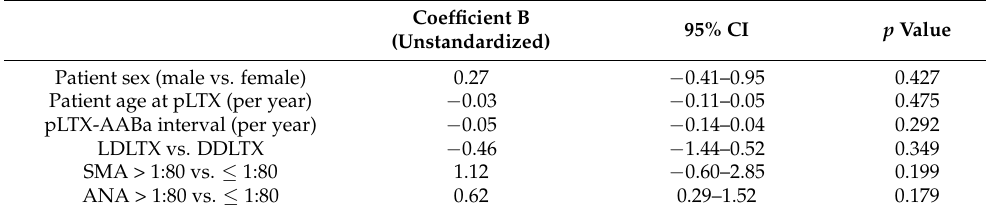
Table 5. Characteristics associated with RAI score (0–9) in multiple linear regression (n = 112). Coefficient B 95% CI p Value (Unstandardized) Patient sex (male vs. female)